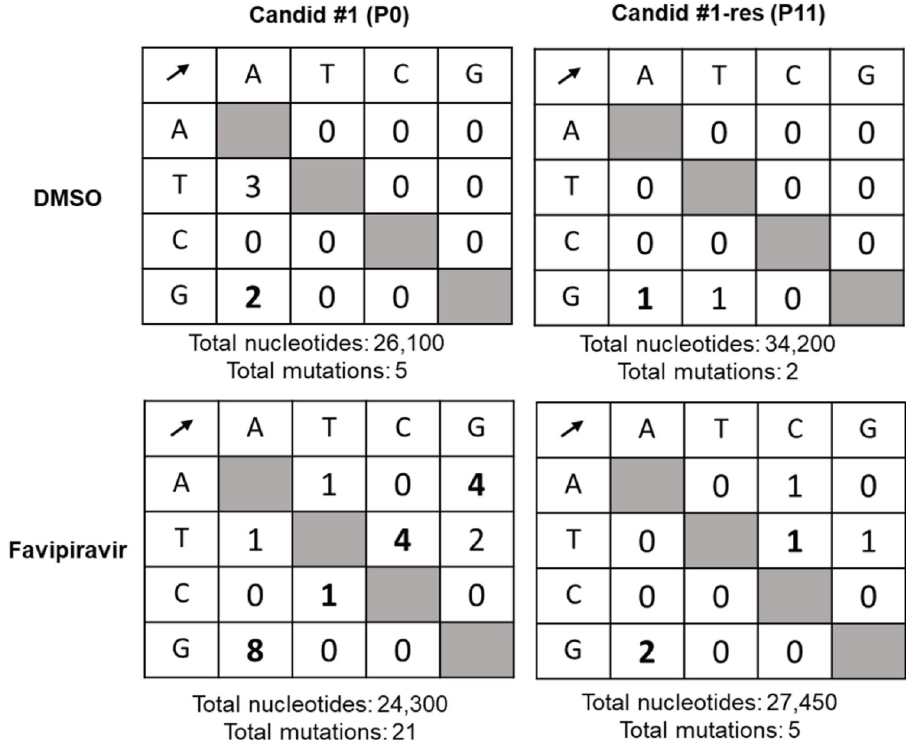
Fig 4. Mutational frequencies of virus populations in presence of 20 μ M favipiravir or DMSO control. Clonal sequencing targeting 450 bp of nucleoprotein (NP) gene was performed (as described in materials and methods) to estimate the frequency of mutations in each virion population. Nucleotide polymorphisms were counted for Candid #1 and Candid #1-res viruses to estimate the proportions of transition (shown in bold) and transversion substitutions in presence of 20 μ M